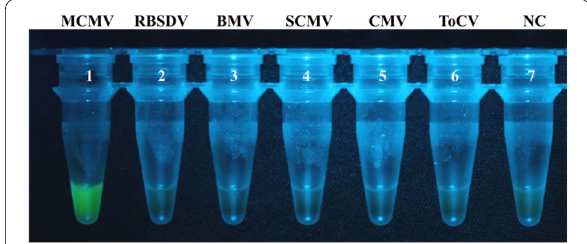
Fig. 4 Specificity test of the established RT-RAA-CRISPR/Cas12a detection for MCMV. The tubes 1 to 7 indicate MCMV, RBSDV, BMV, SCMV, CMV, ToCV and ddH 2 O, respectively